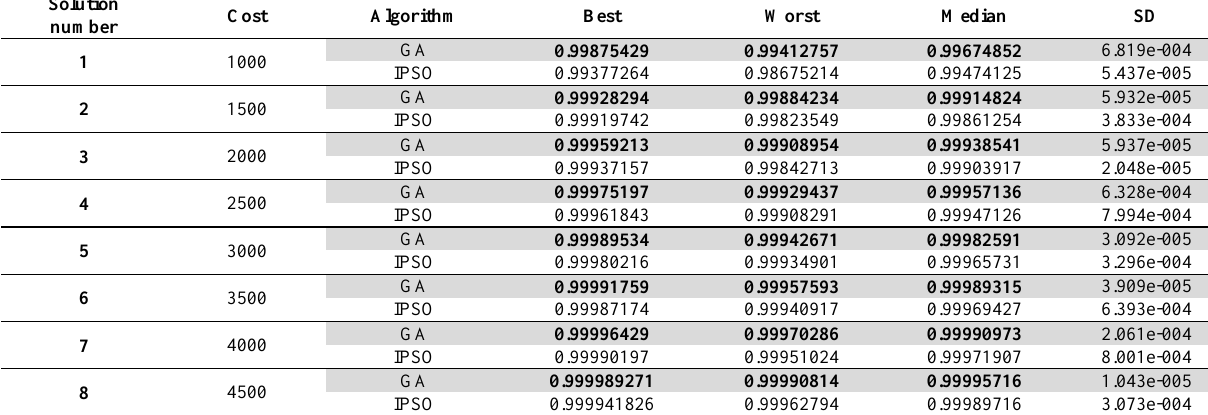
Comparison of results for example between GA and IPSO